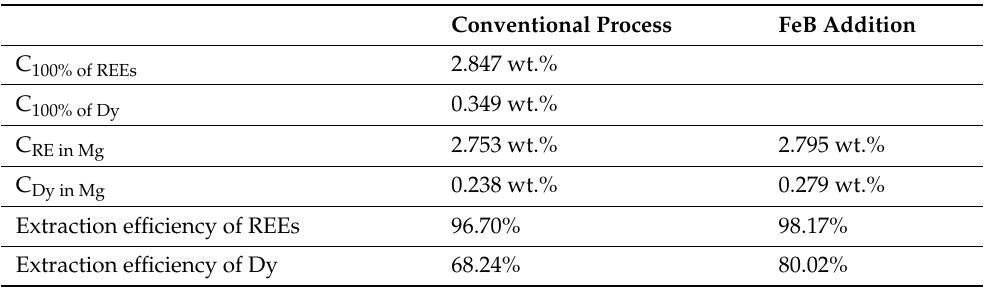
Table 4. Concentration and extraction efficiency of REEs and Dy in the conventional process and FeB addition process.